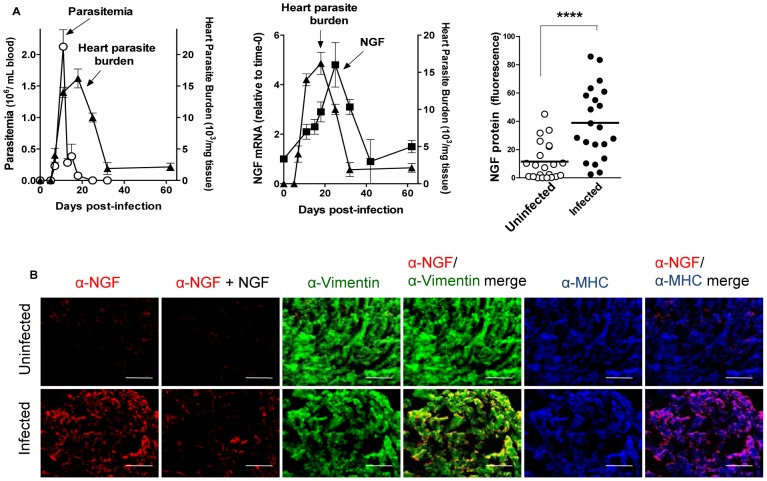
T cruzi infection of the heart upregulate NGF selectively in cardiac fibroblasts.
A) Upregulation of NGF in the myocardium trails parasitemia and heart parasitism. C57BL/6 mice (2 or 3/point) were infected with T cruzi and their parasitemia, cardiac parasite burden and NGF levels determined at the indicated times post-infection (PI). Left panel shows that cardiac parasite burden trails parasitemia. Cardiac parasite burden is a composite of three separate experiments. Middle panel shows the kinetics of cardiac NGF transcript in response to T cruzi infection, which trails heart parasitism. Right panel displays cardiac NGF protein levels from 20-d PI and vehicle-injected uninfected mice. The results are combined from three independent experiments (n = 22) and show a significant increase in NGF in infected hearts, **** P<0.0001B) NGF is preferentially localized in cardiac fibroblasts of T cruzi-infected hearts. The images are representative from the results presented in (B), right panel. Note the specificity of NGF visualization, as it is nearly completely blocked by preincubating the NGF antiserum with purified soluble NGF (200 ng/ml) (compare first and second bottom panels, from the left); and the preferential co-localization of NGF on cardiac fibroblasts (yellow color in the α-NGF/α-vimentin merge); scale bars = 100 µm.